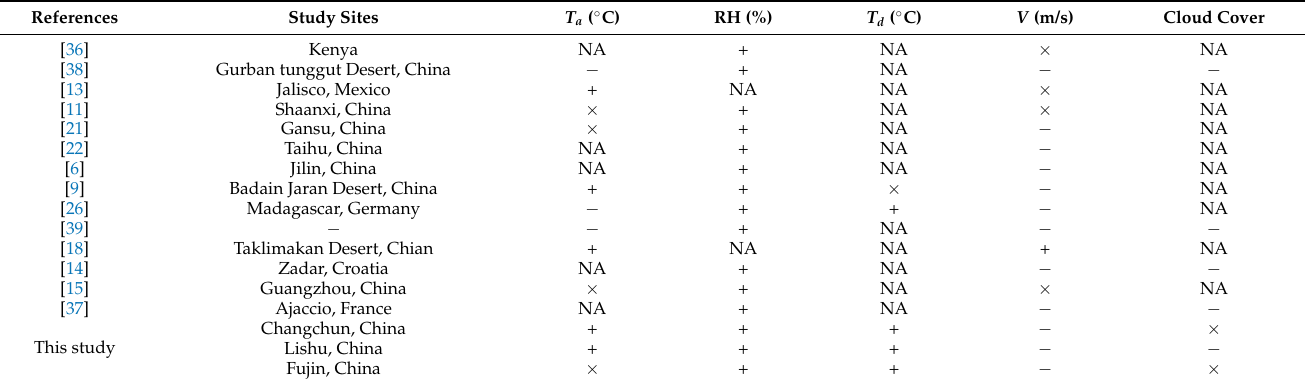
Table 4. Meteorological factors affecting dew intensity at reported